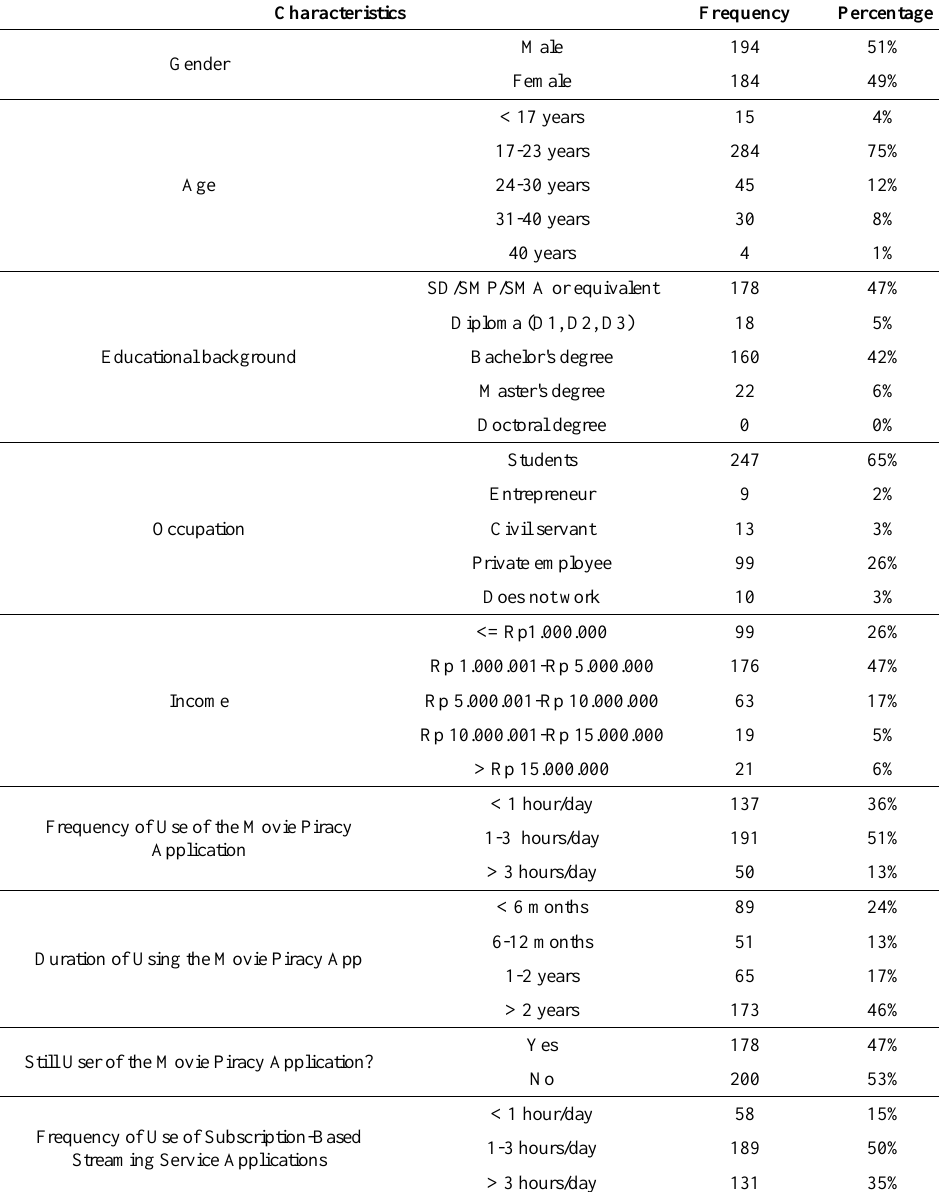
Figure 3. Frequency of using movie piracy applications Table 2. Characteristics of the